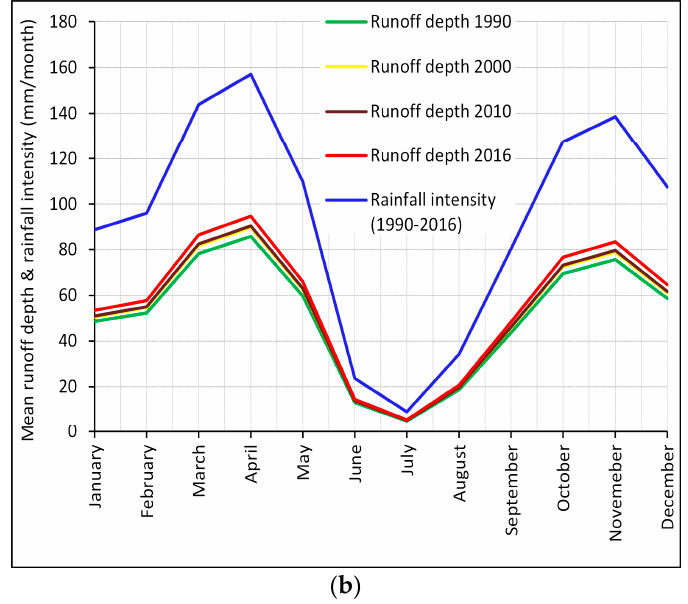
Figure 9. ( a ) Annual runoff depth in response to land use change (LUC ‐ ONLY) and the combined effects of land use and climate changes (OVERALL) in Rwanda; and ( b ) The average monthly runoff depth under the LUC ‐ ONLY scenario.